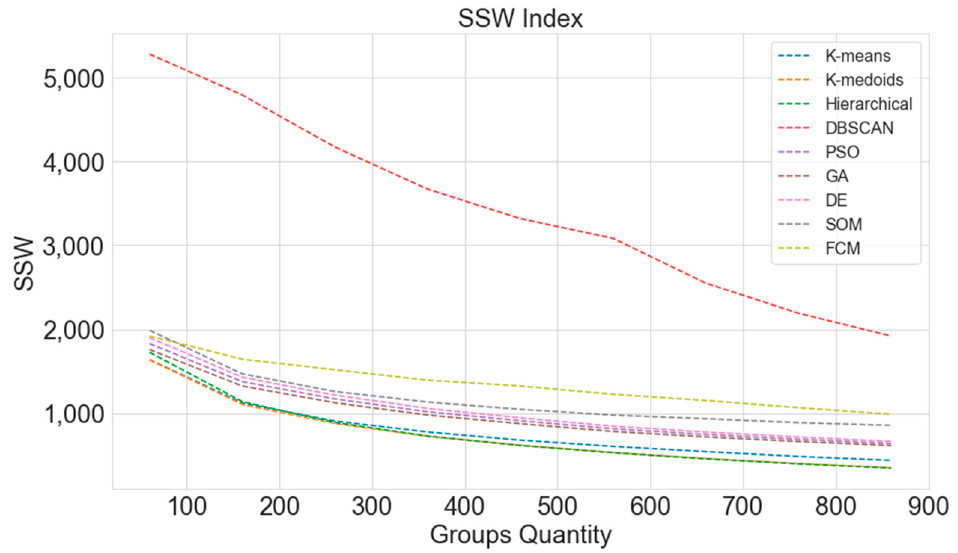
Figure 7. SSW index evaluation over different group amounts considering nine clustering methods.